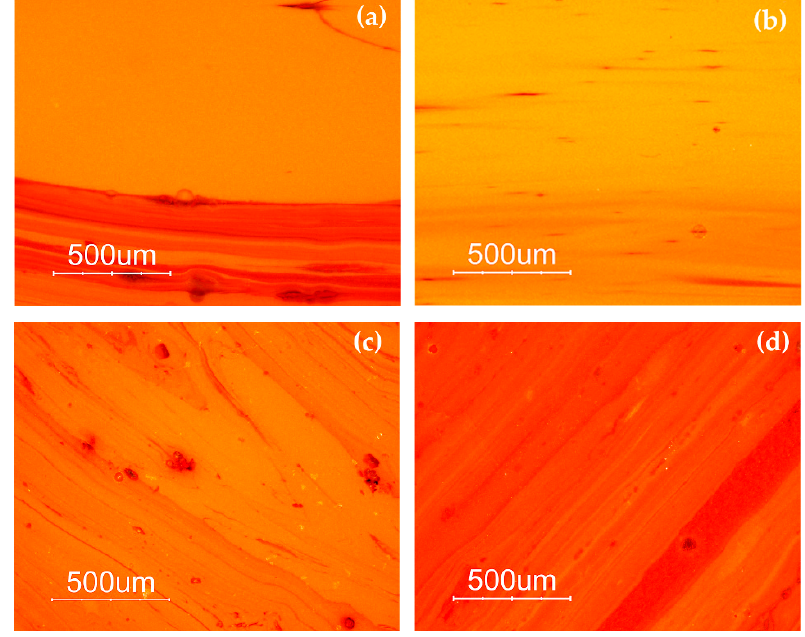
Figure 5 . Optical micrographs in dark field objective: AR1 ( a ); AR2 ( b ); AR6 ( c ) AR4 ( d ).